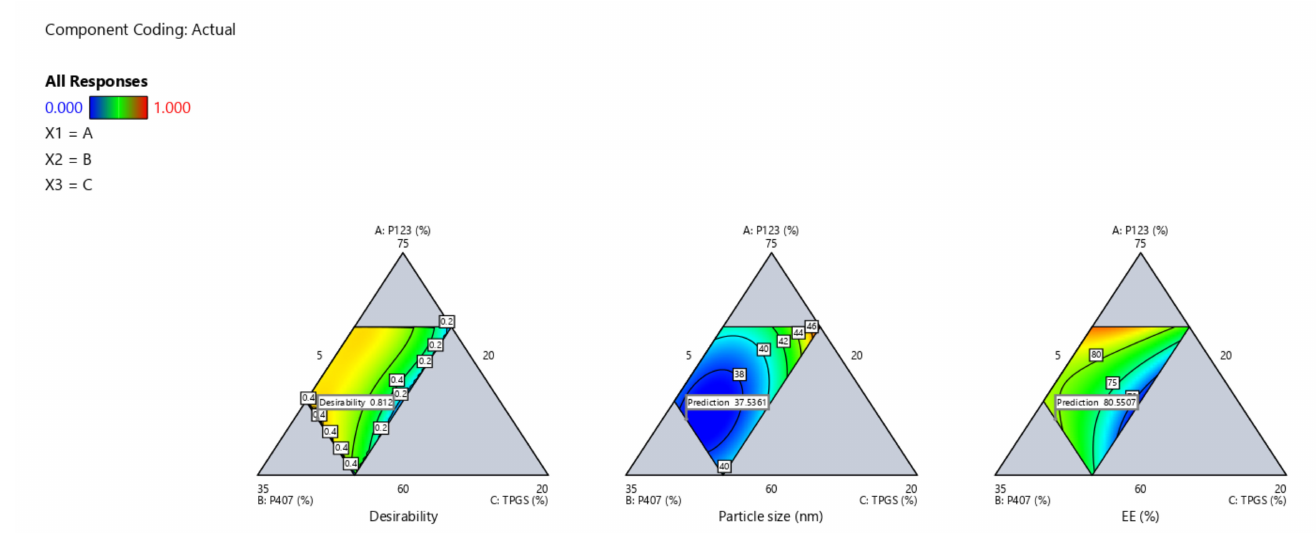
Figure 4. Contour plot for the OZ–PM desirability.